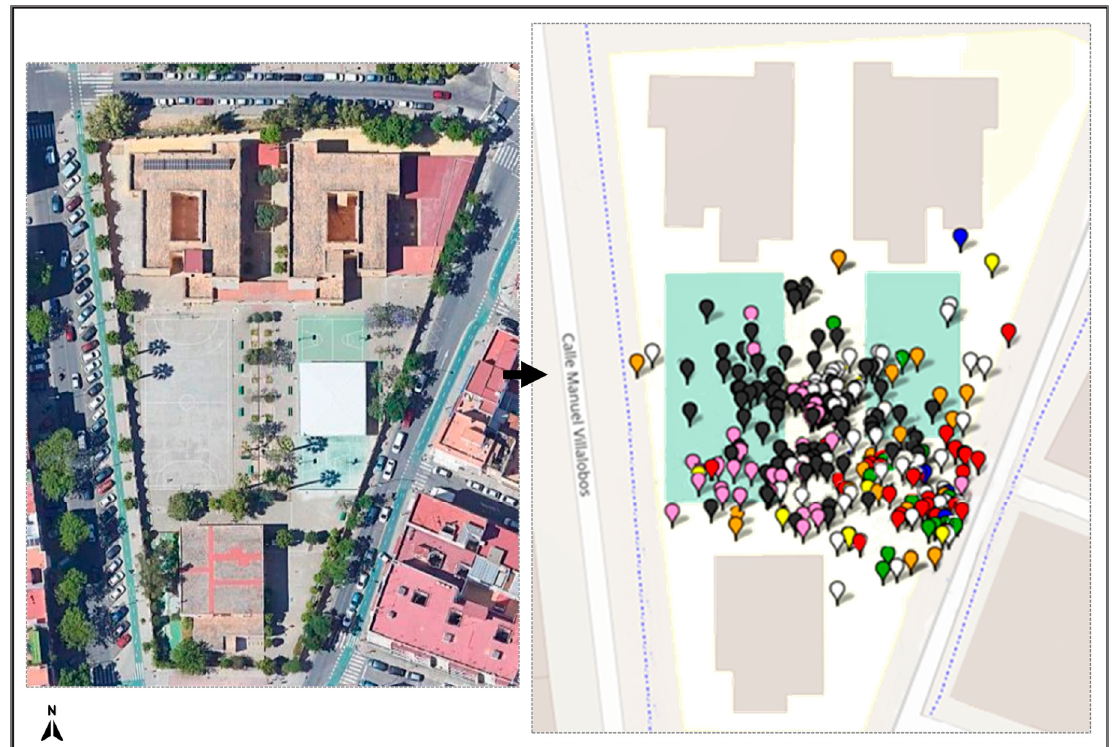
Figure 13. Geolocation of the interviews.